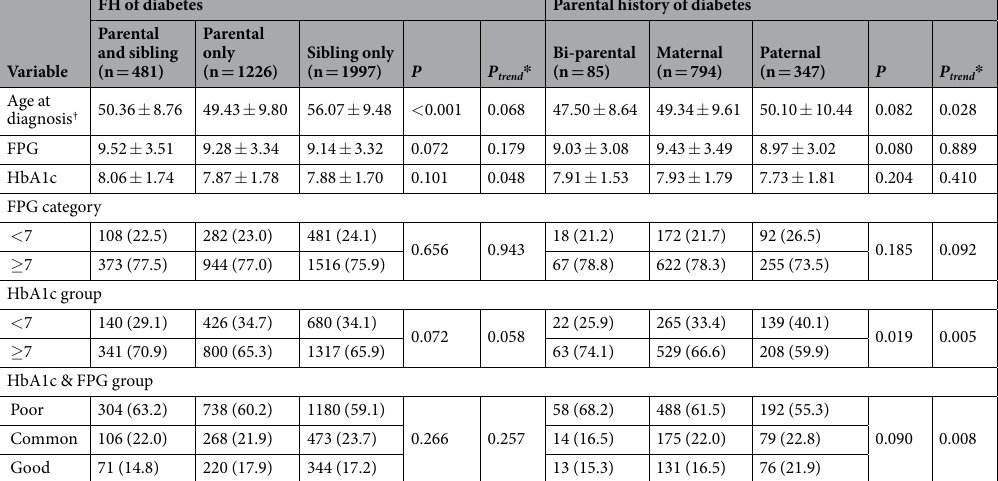
FH group (vs. Absence)